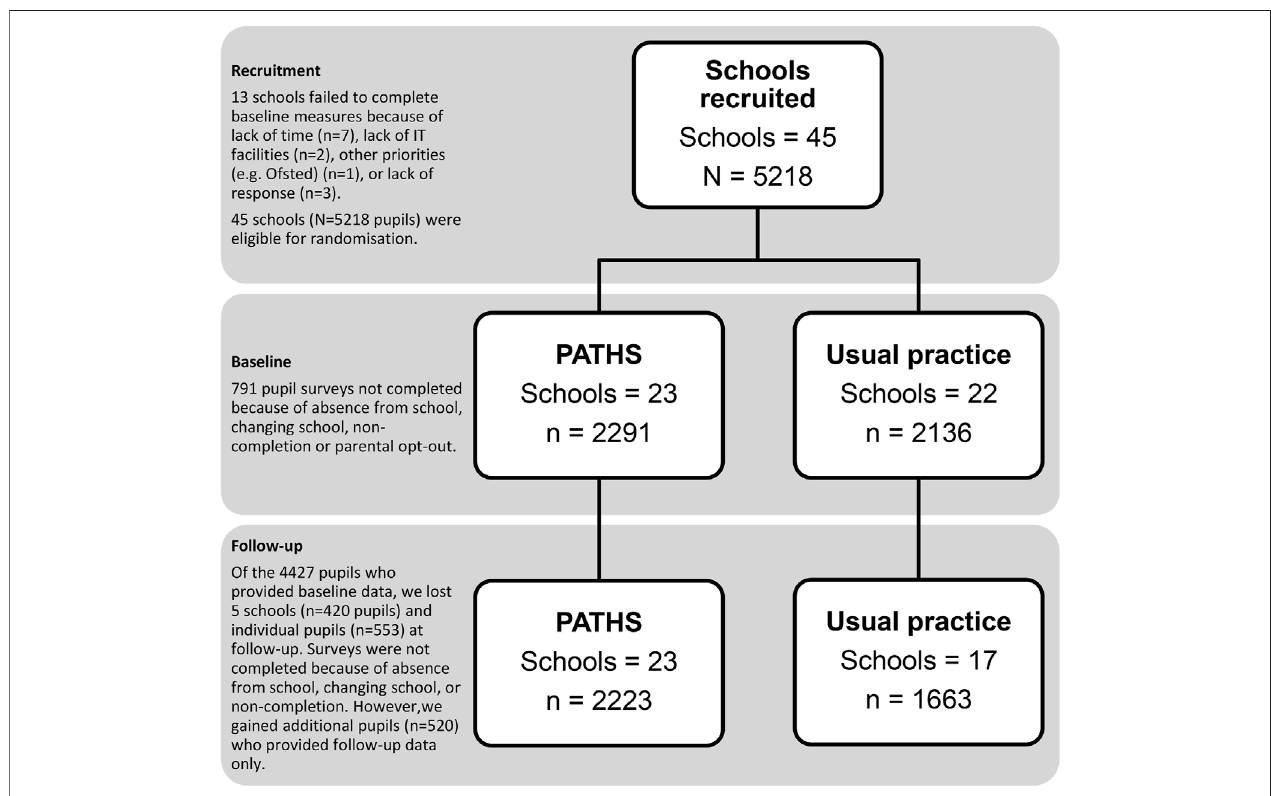
FIGURE 1 | Consort diagram depicting fl ow of participants through